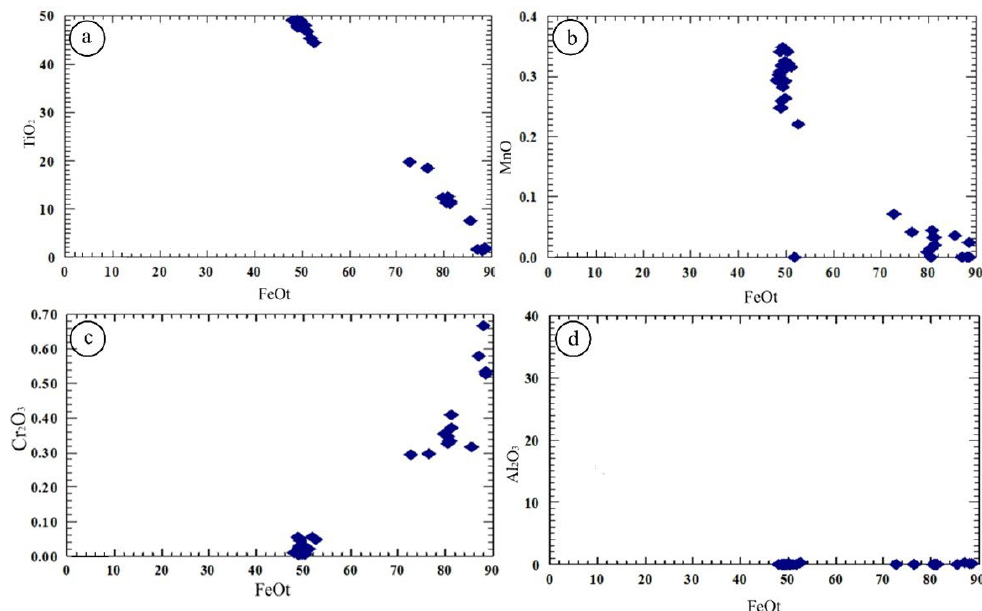
Figure 11. Binary plots of concentrations of wt.% of some elements versus FeO t for ilmenite and titano-magnetite in the Abu Ghalaga gabbro intrusion. ( a ) TiO 2 ; ( b ) MnO; ( c ) Cr 2 O 3 ; ( d ) Al 2 O 3 .